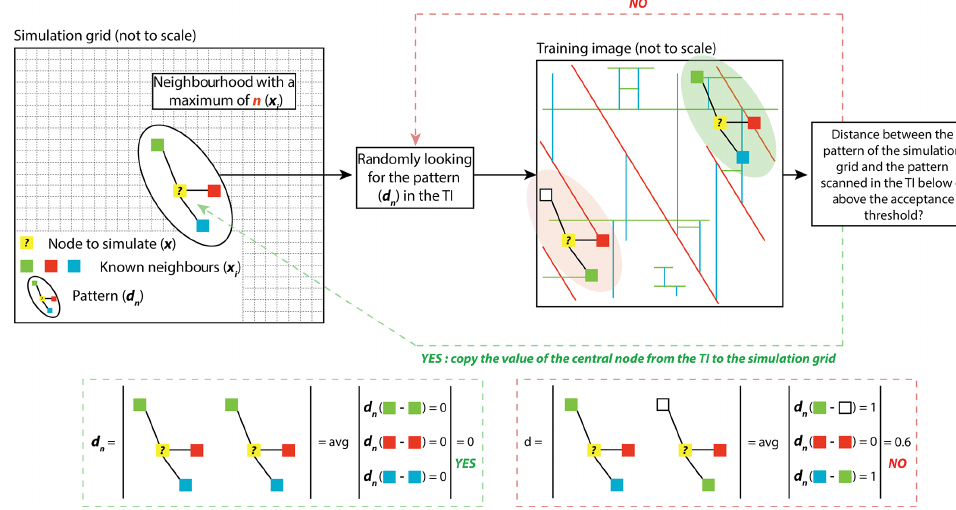
Figure 1. Direct sampling method workflow applied to fracture network modelling (modified from Meerschman et al.,